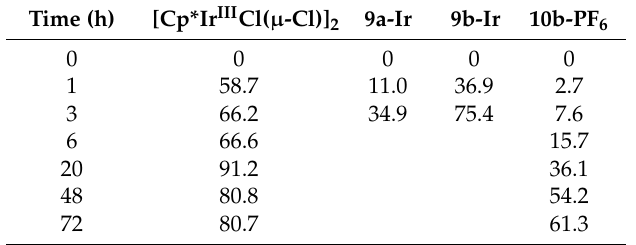
Table 2. Yields (%) of product over time (h) using 9a-Ir , 9b-Ir , 10b-PF 6 , or [Cp*Ir III Cl( µ -Cl)] 2 [a] . Time (h) [Cp*Ir III Cl( µ -Cl)] 2 9a-Ir 9b-Ir